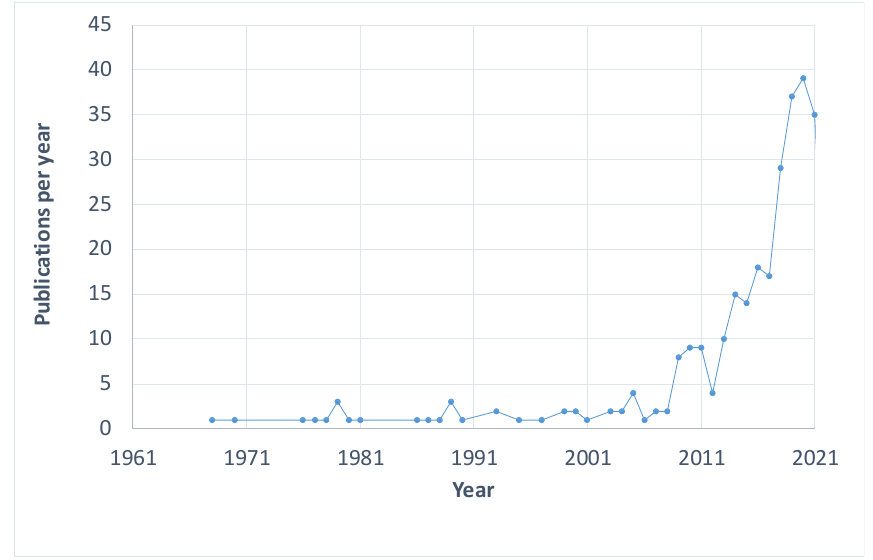
Figure 3. Trends in number of publications.